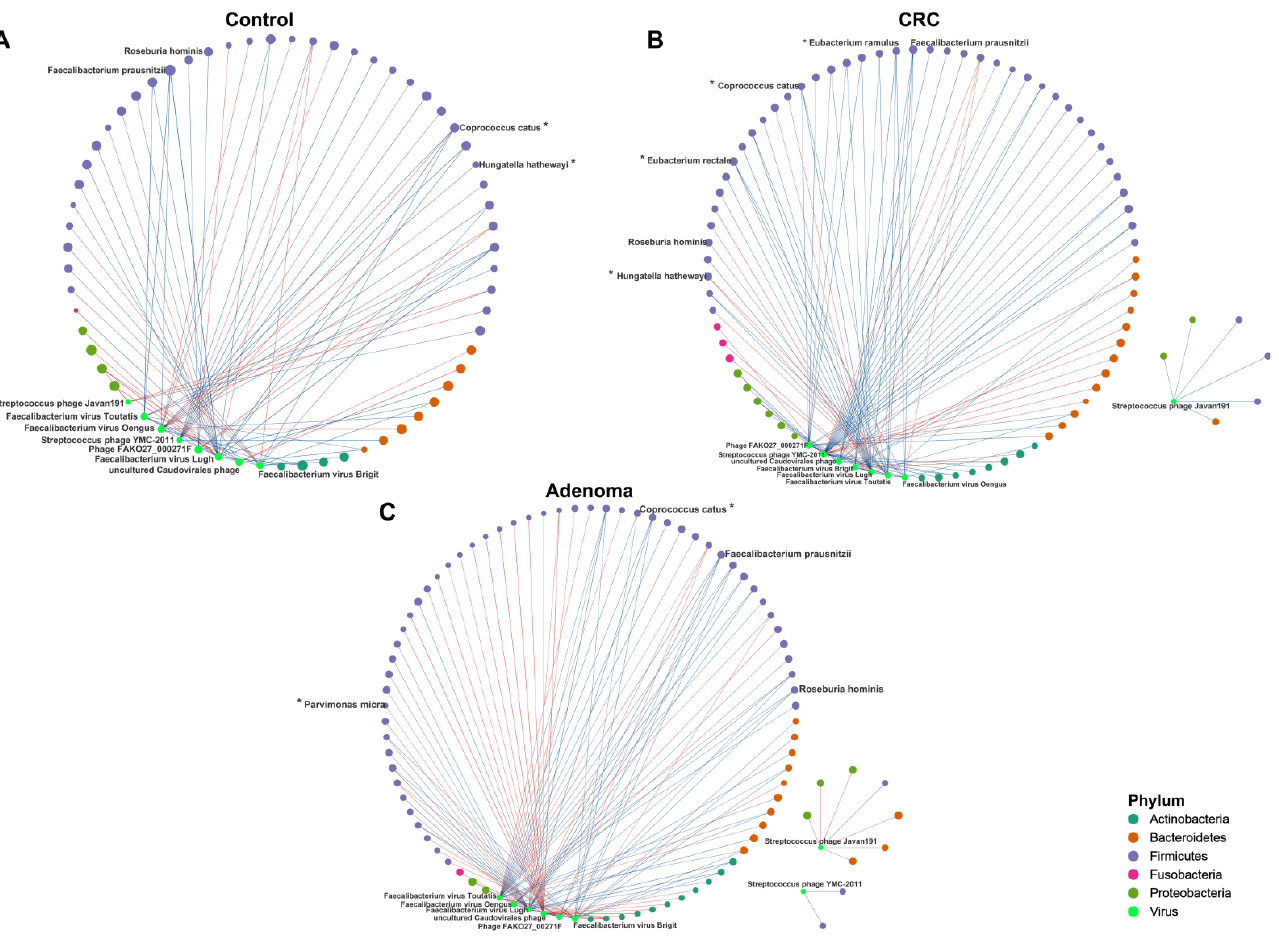
Figure 7. The correlation networks between the viral markers and bacterial species in the control ( A ), CRC ( B ), and CRA ( C ) groups. Lines between dots indicate the significant correlation of species ( p < 0.05). The blue line indicates a positive correlation, and the red line indicates the presence of a negative correlation. The size of the node is proportional to the relative abundance of species. The nodes are colored according to the phylum to which the species belongs. *, bacterial markers screened by the random forest model. Viruses marked with green node are eight viral markers.